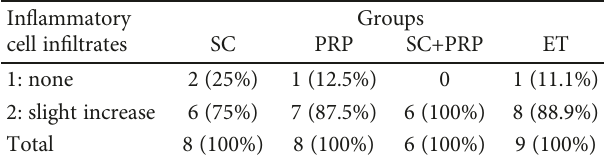
Table 4: Analysis of in fl ammatory cell in fi ltrates.